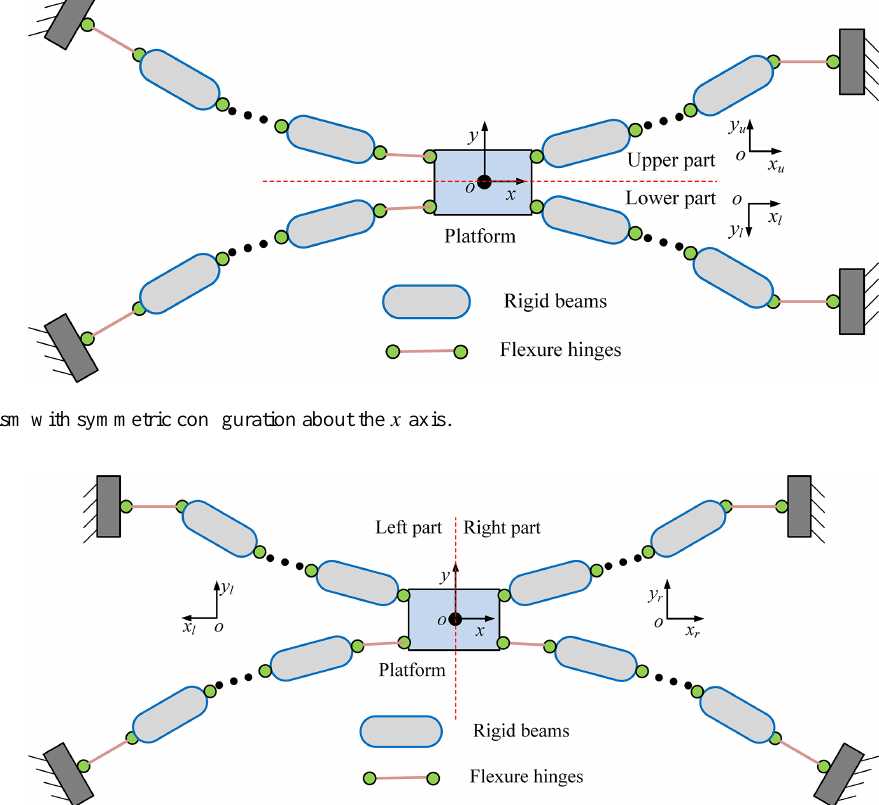
Figure 4. Mechanism with symmetric configuration about the y